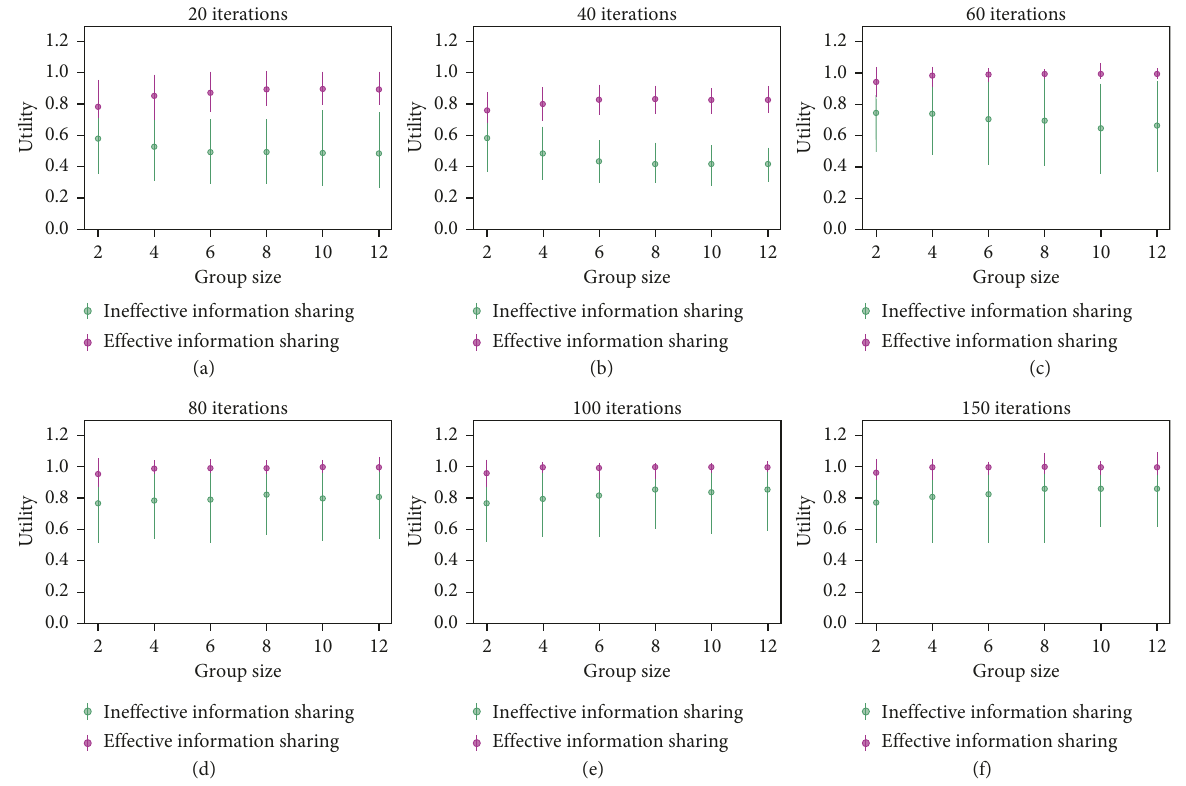
Figure 9: Bar plots regarding the effects of information sharing on group performance for the 4-peak problem